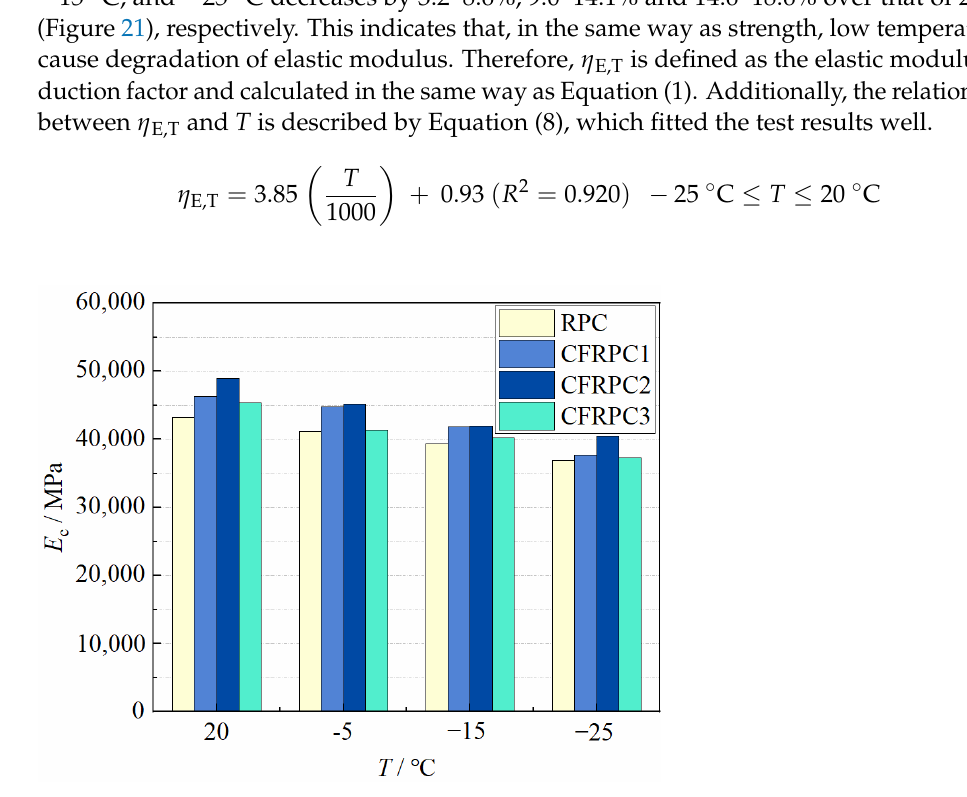
Figure 21. Relationship η E,T vs. T. From the experimental results of this paper and references [49,50], it can be seen that the elastic modulus increases with the increase of strength, but they are not directly pro- portional. Based on the test data, the relationship between the elastic modulus E c and the